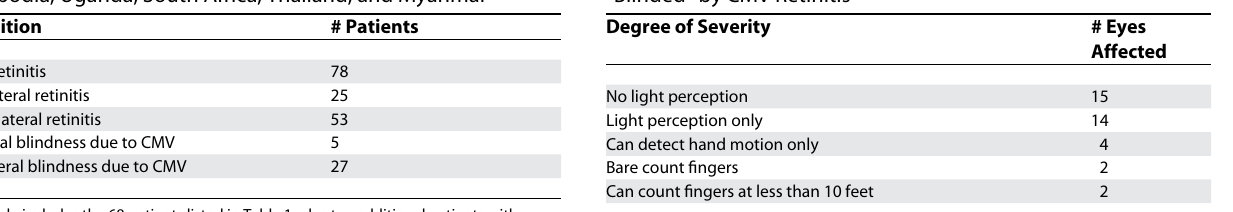
Table 3. Severity of Vision Loss in 37 Eyes (of 32 Patients) “Blinded” by CMV